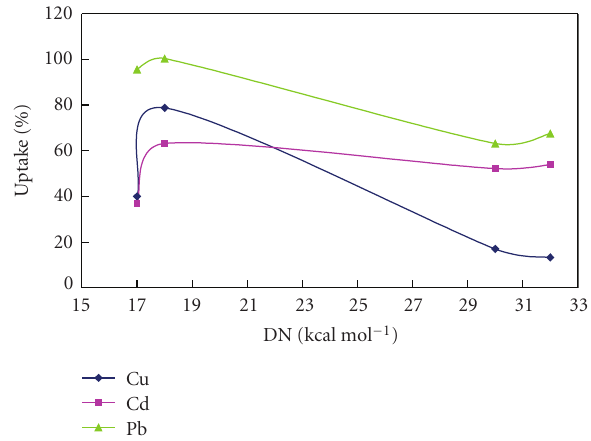
Figure 1: The e ff ect of donor numbers on the percentage uptake of metal ions in di ff erent solvents.